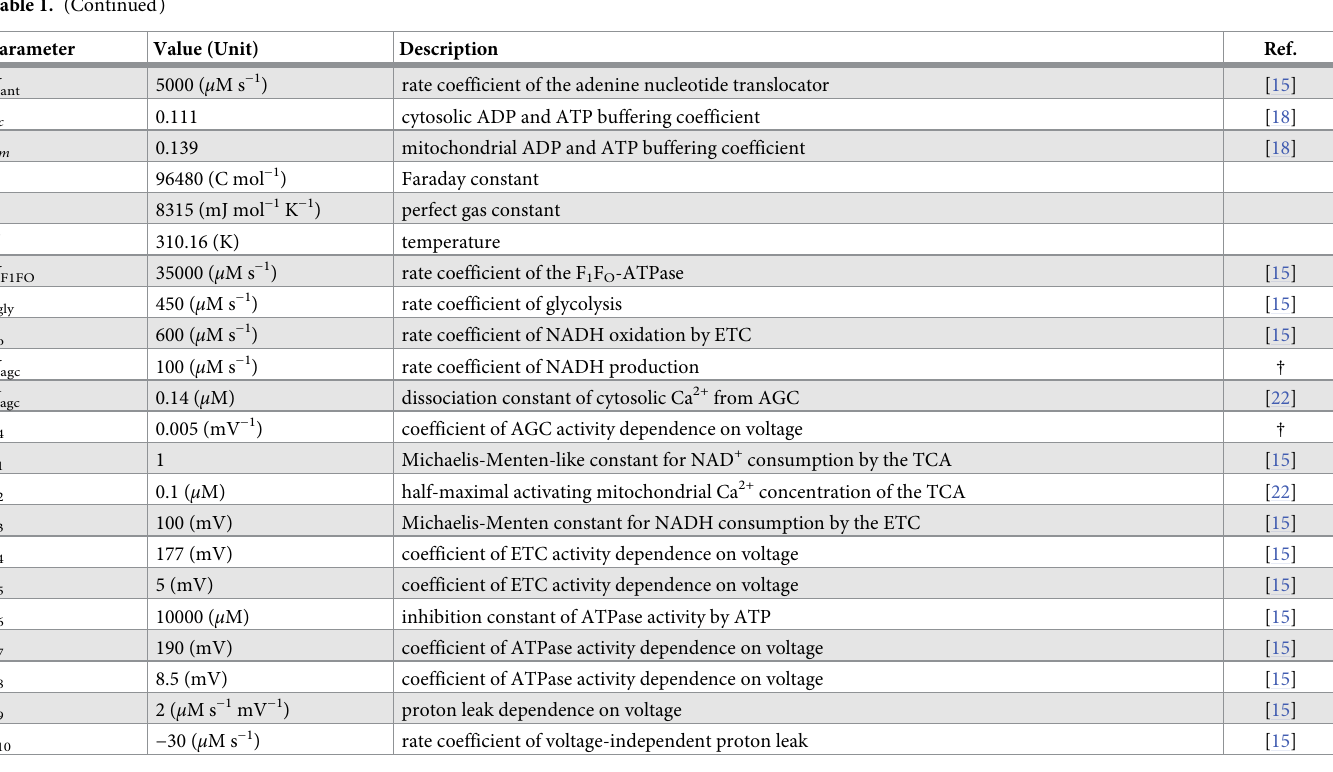
• J : Ca 2+ influx across the plasma membrane through store-operated Ca 2+ channels in (SOCCs), receptor-operated Ca 2+ channels (ROCCs), and a constant small influx : Ca 2+ efflux across the plasma membrane through the plasma membrane Ca 2+ ATPase • J pm (PMCA)